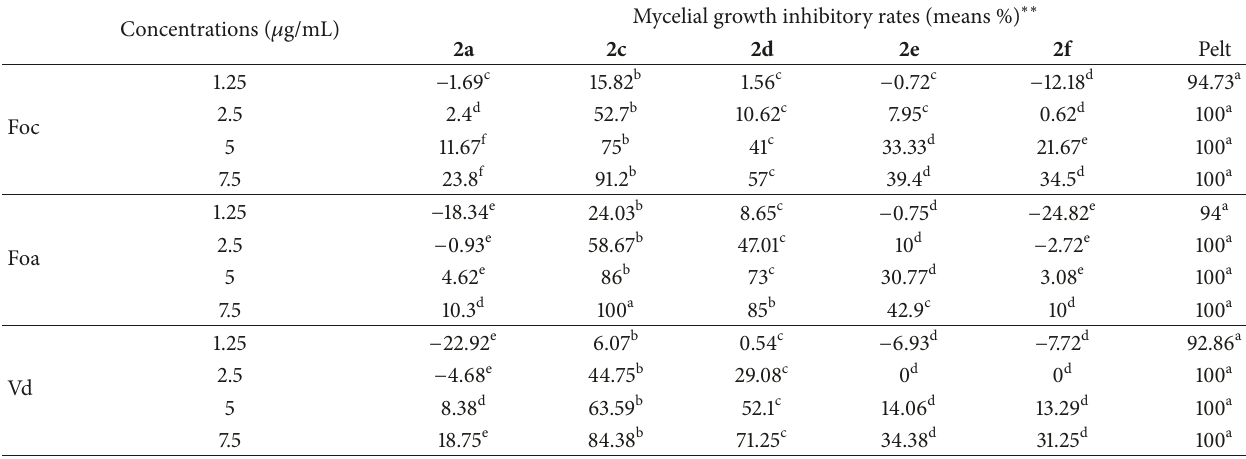
Table 2: Linear growth inhibition of (Foc, Foa, and Vd) under the effect of different concentrations of the polyorganochlorine derivatives ( 2a – f ) in comparison with the control, after 8 days of incubation at 28 ∘ C on Czapek medium. Concentrations ( 𝜇 g/mL)